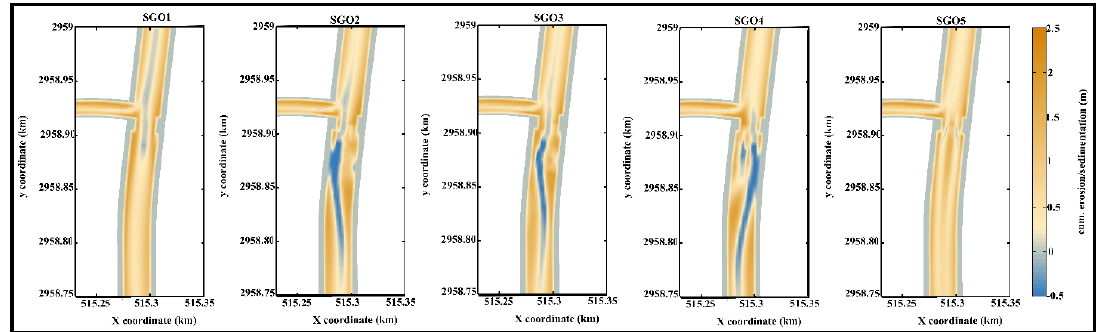
Figure 12. Cumulative erosion/sedimentation by opening two gates compared to the reference case.